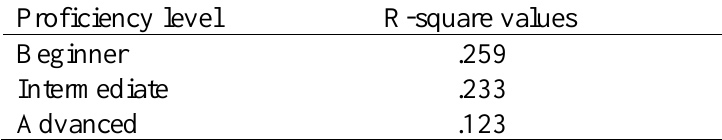
Regression on Motivation and Aptitude on